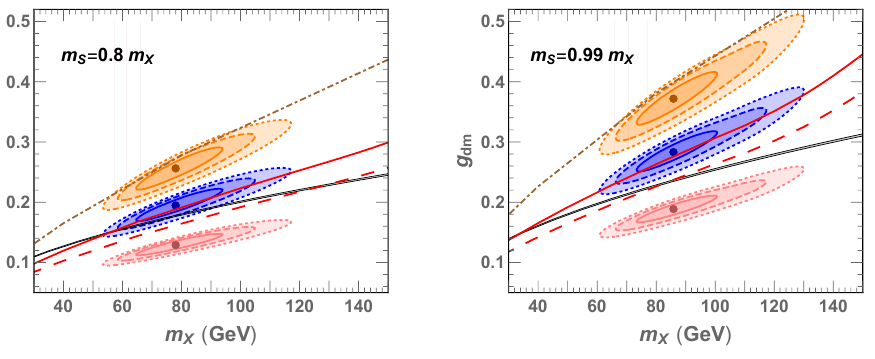
Figure 7 . Same as (cid:12)gure 6, but in the ( m X ; g dm )